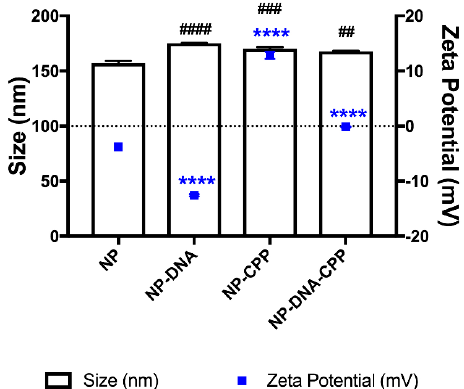
Figure 1. Particle size (columns) and zeta potential (dots) of nanoparticles (NPs) coated with or without cell-penetrating peptides (CPPs), before and after pDNA encapsulation. ( n = 3 ± StDev; Statistical difference in size is shown in hash (#) and for zeta potential in stars (*). **** P < 0.0001; ## P < 0.01; ### P < 0.001; #### P < 0.0001).